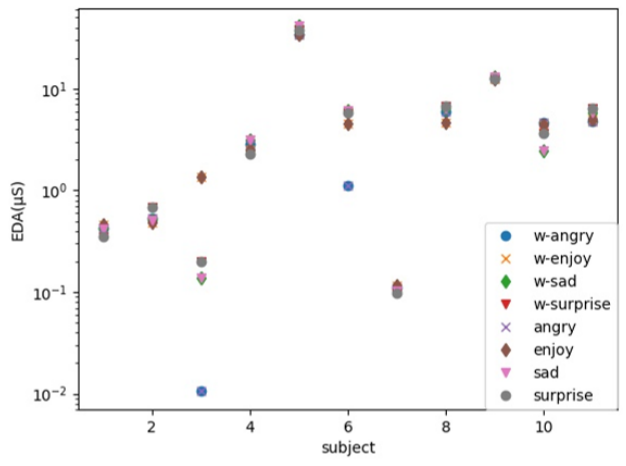
Figure 5. Average of recognition rate in all